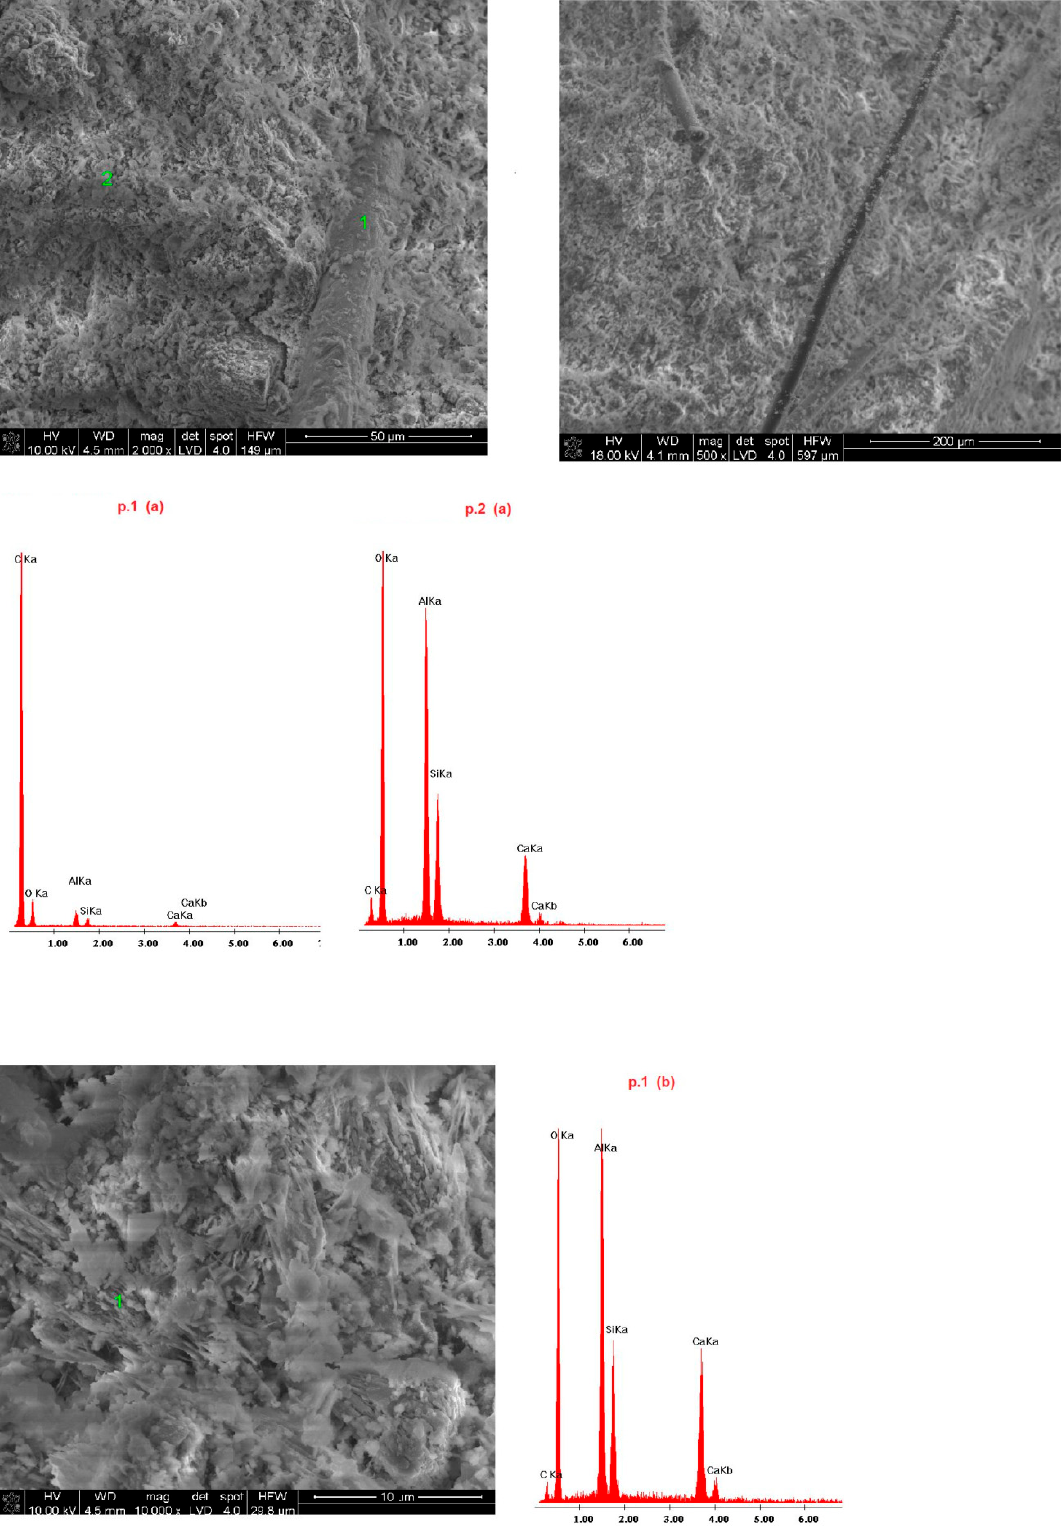
Figure 11. SEM microphotograph and EDS analysis of sample 3.